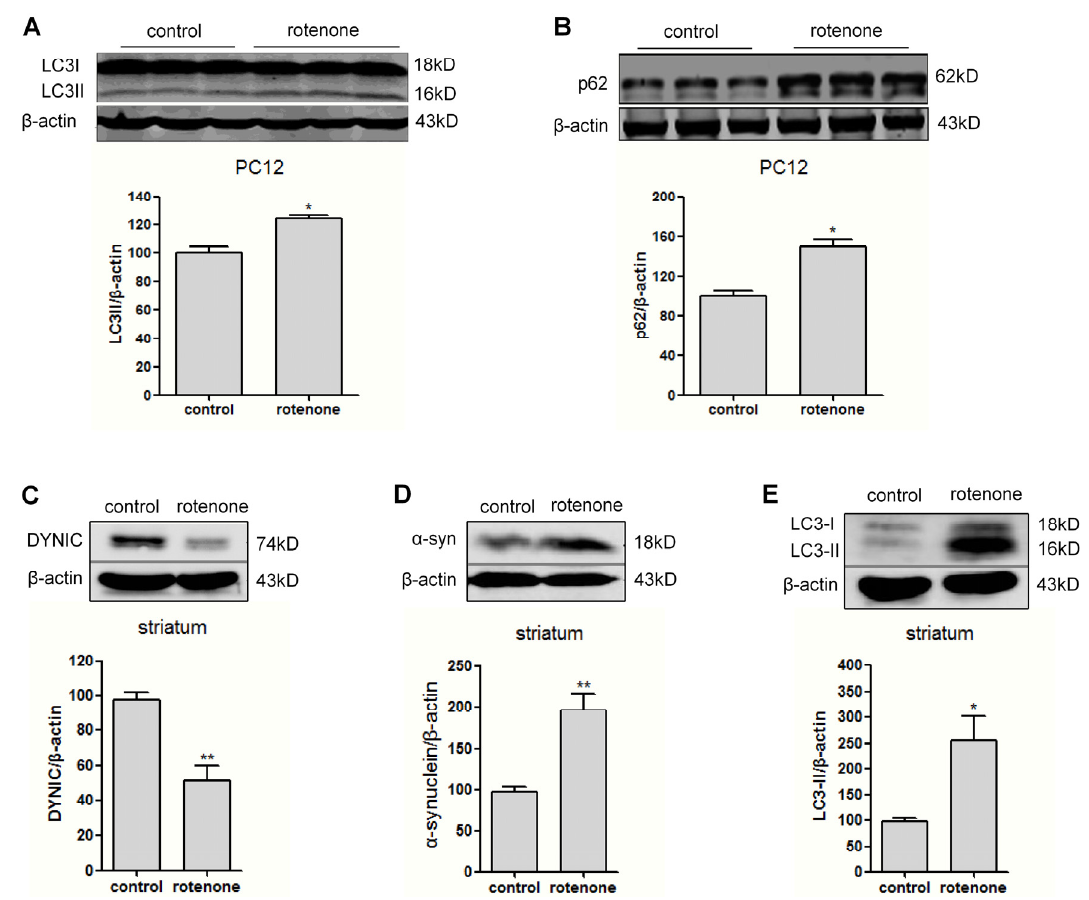
Figure 3. Upregulation of autophagic markers LC3-II and p62, associated with DYNIC decreases in rotenone-intoxicated PC12 cells and rat striatum. ( A , B ) LC3II and p62 levels were determined by western blot in PC12 cells exposed to 0.5 µM rotenone or vehicle for 24 h; and ( C – E ) Striatum was isolated from animals sacrificed at 30 days after subcutaneous injection of either vehicle or rotenone at a low dose of 1.0 mg kg − 1 ·d − 1 . Protein levels of DYNIC, α -synuclein and LC3 from three independent rat striatum were examined by western blot. Results were expressed as mean ± SEM, n = 3. * p < 0.05; ** p < 0.01 versus